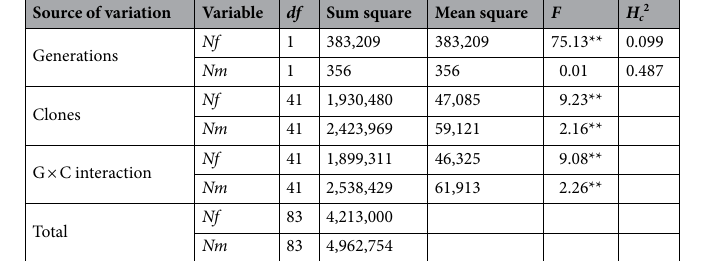
Source of variation